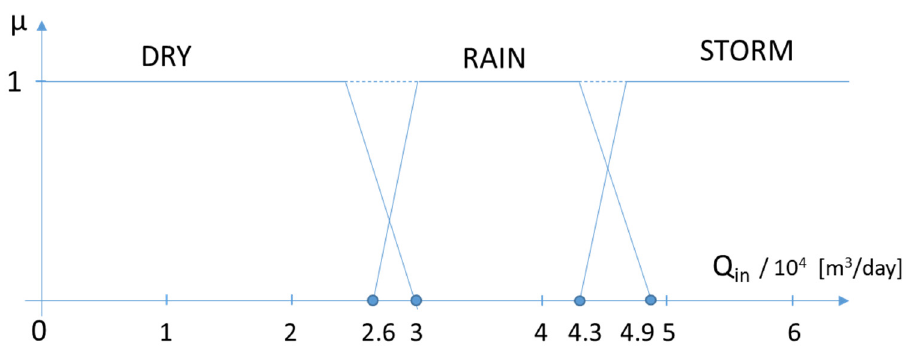
Figure 6. Membership functions of Q in to the operating regimes.